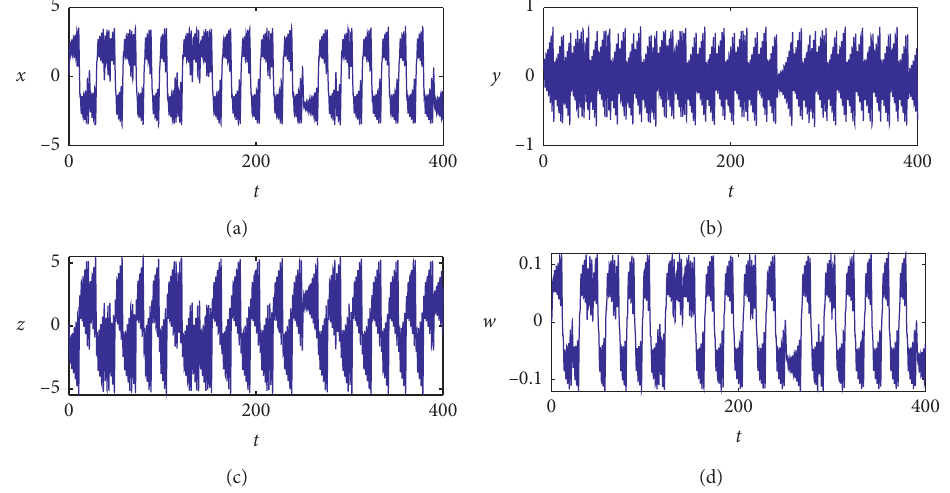
Figure 4: Time-domain waveforms of chaotic system (3).